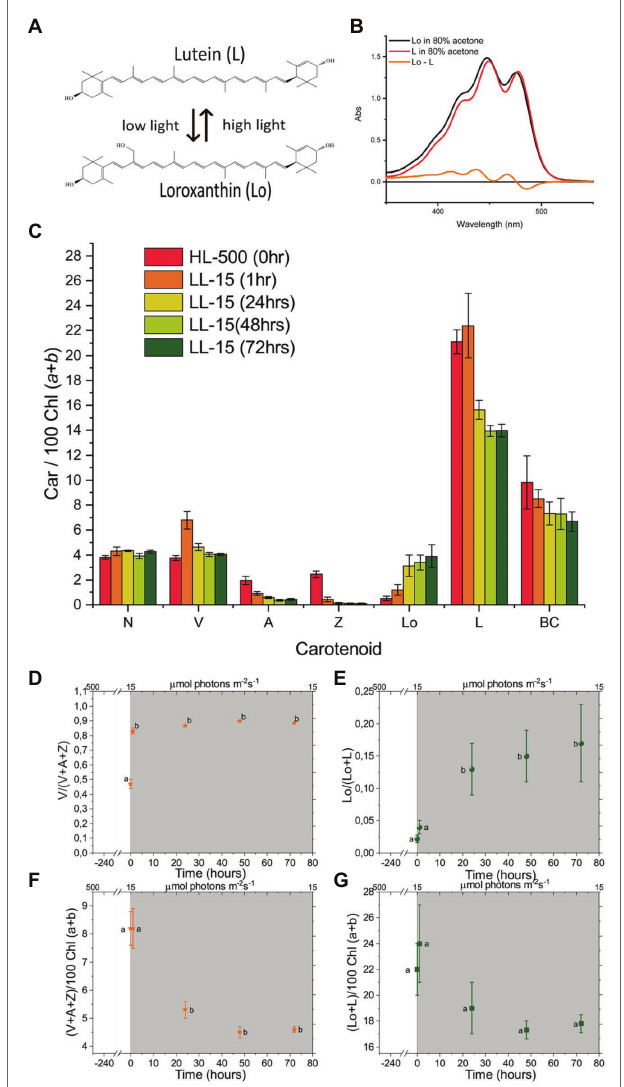
FIGURE 2 | Spectra of Loroxanthin (Lo) and Lutein and the changes in their content at different light intensities. (A) Chemical structures of L and Lo and an illustration of their relationship at different light intensities. (B) Absorption spectra of Loroxanthin and Lutein in 80% acetone. The difference spectrum is also shown. (C) Carotenoid composition [relative to 100 Chl ( a + b )]. The number in the legend indicates the light intensity in μ mol photons m − 2 s − 1 . (D) Violaxanthin – Antheraxanthin – Zeaxanthin cycle (VAZ) epoxidation state, (E) LLo hydroxylation state and VAZ (F) as well as LLo (G) pool size [relative to 100 Chl ( a + b )] of Chlamydomonas reinhardtii cells at different time points (0, 1, 24, 48, and 72 h) following the shift of the culture from continuous HL to continuous LL ( D–G , gray area). Averages represent two technical replicates per five biological replicates per timepoint. Error bars represent the SE. Letters (a, b) indicate significant differences between groups (ANOVA). N, Neoxanthin; V, Violaxanthin; A, Antheraxanthin; Z, Zeaxanthin; Lo, Loroxanthin; L, Lutein; and BC, β